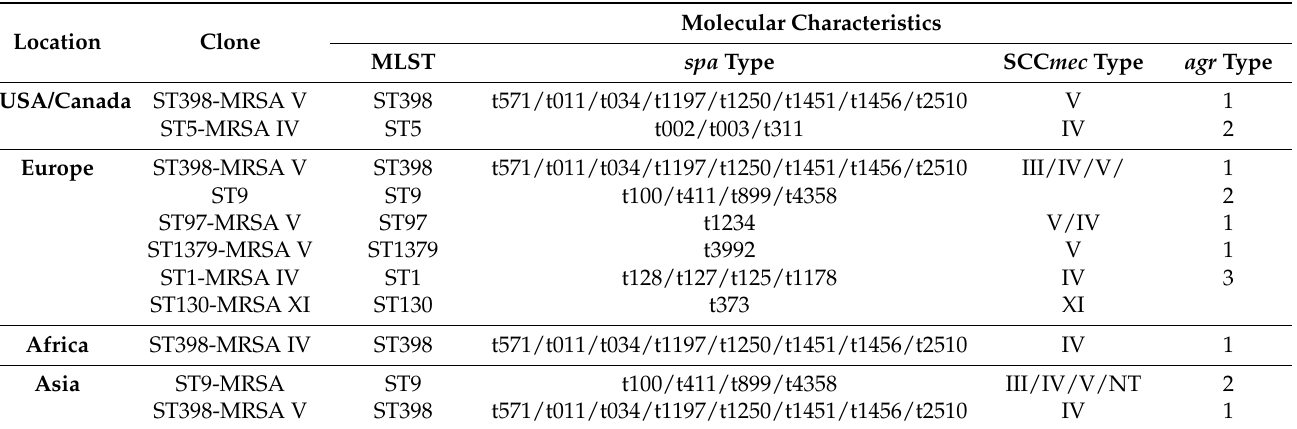
Table 2. Molecular characteristics of LA-MRSA clones in different continents